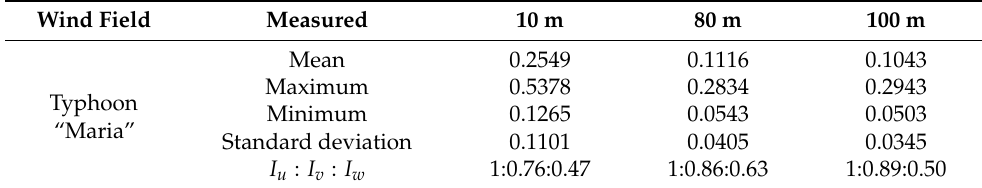
Table 1. Summary of the measured turbulence intensities.